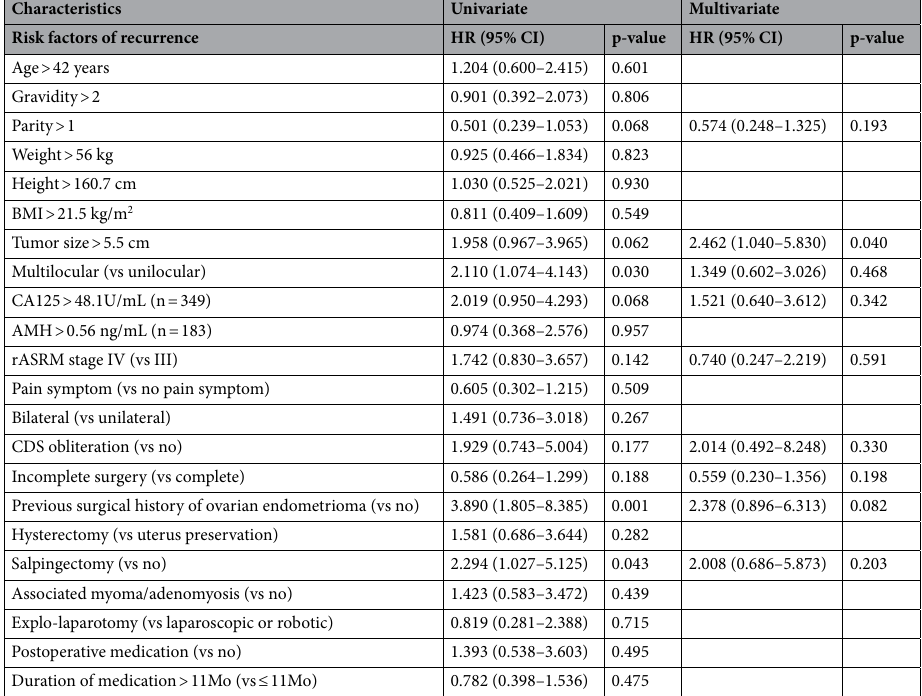
Table 4. Univariate and multivariate analysis for independent risk factors of recurrent ovarian endometrioma by Cox proportional hazards models (n = 408). HR, hazard ratio; CI, confidence interval; BMI, body mass index; CA125, cancer antigen 125; AMH, anti-Mullerian hormone; rASRM, revised American Society for Reproductive Medicine; CDS, cul-de-sac; d/t, due to; endo, endometriosis; Mo,